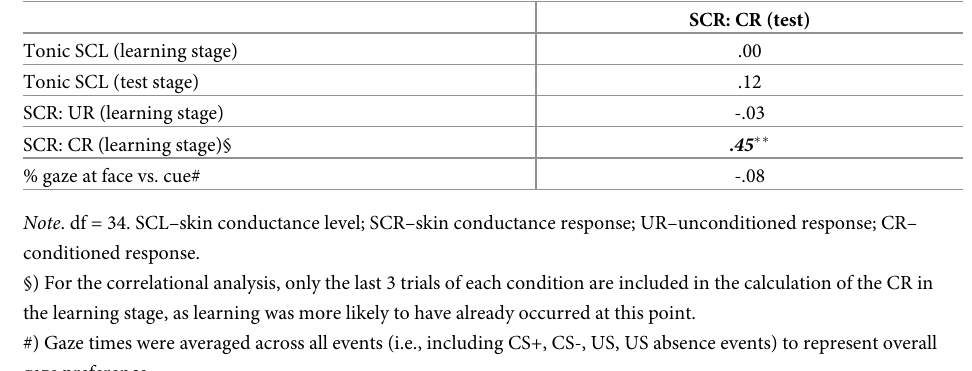
Table 1. Spearman correlations among the differences in SCL, SCR and eye gaze observed between hypnotically induced high and low affect sharing in N = 36 participants (controlling for order). Tonic SCL (learning stage)